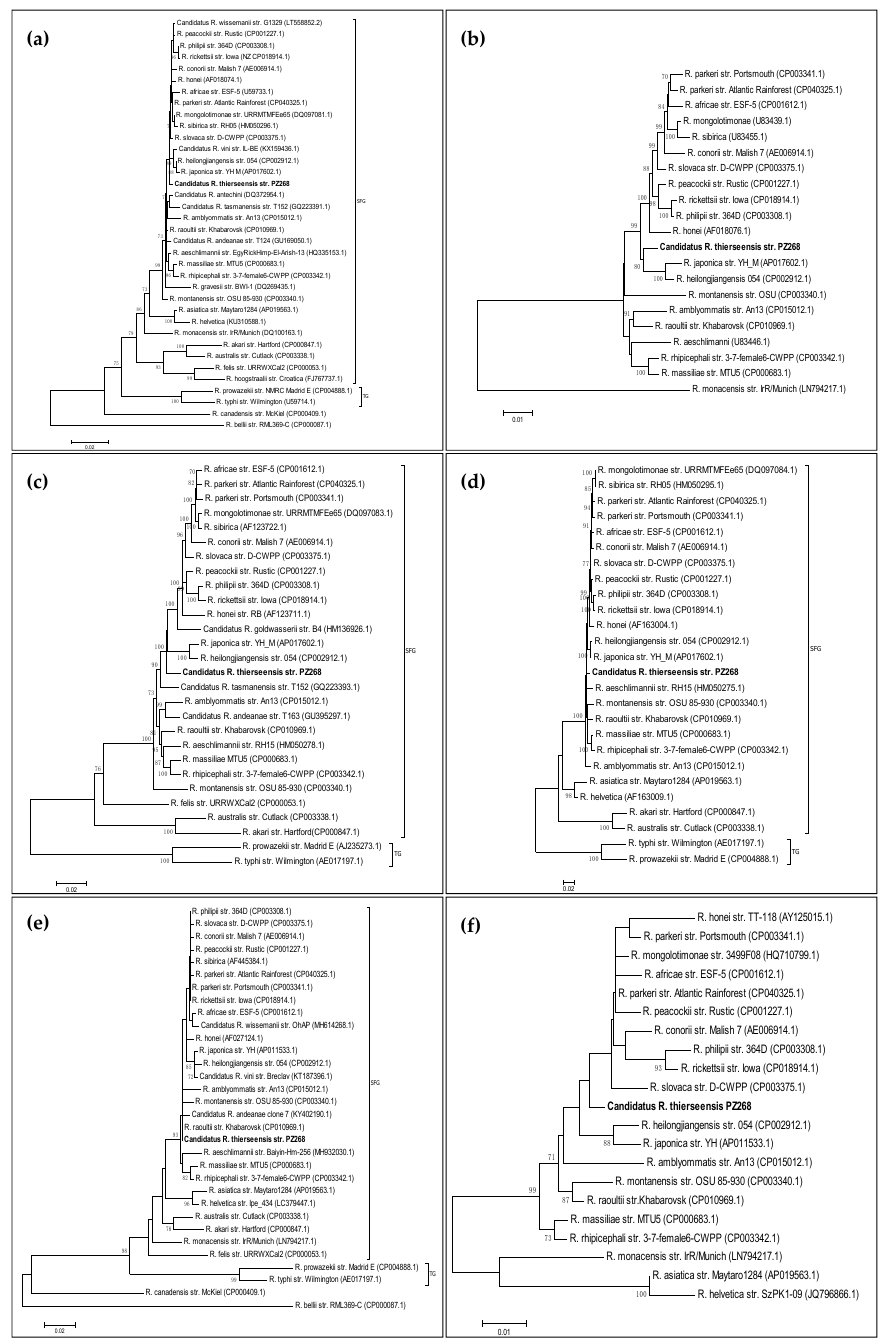
Figure 1. Phylogenetic trees for single genes. Neighbor-joining trees constructed with the Kimura 2-parameter method and inferred from 1000 bootstrap replicates. Only bootstrap values ≥ 70% are shown. The trees were drawn to scale with branch lengths indicating evolutionary distances. Gaps and missing data were deleted. Our strain under study is displayed in bold letters. ( a ) gltA gene showing 36 Rickettsia strains using a total of 1051 positions in the final dataset; ( b ) ompA gene including 21 strains and 3144 positions; ( c ) ompB gene including 28 strains and 4739 positions; ( d ) sca4 gene displaying 26 strains and constructed from 2010 positions; ( e ) htrA gene showing 32 strains using 413 positions; ( f ) 23S-5S intergenic spacer region for 21 strains and built from 345 positions in the final